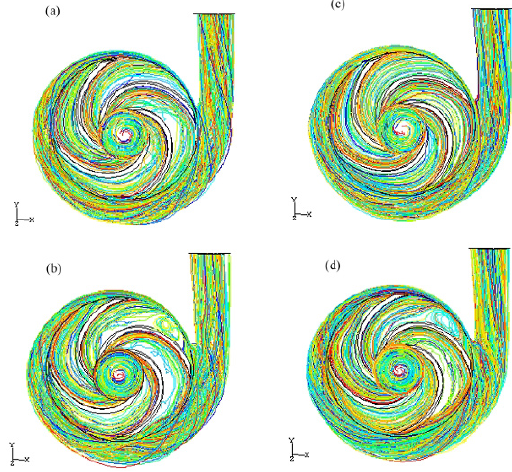
Figure 9. Water and viscous oil flow pathlines in impeller and volute at best efficiency and part-loading points, (a)